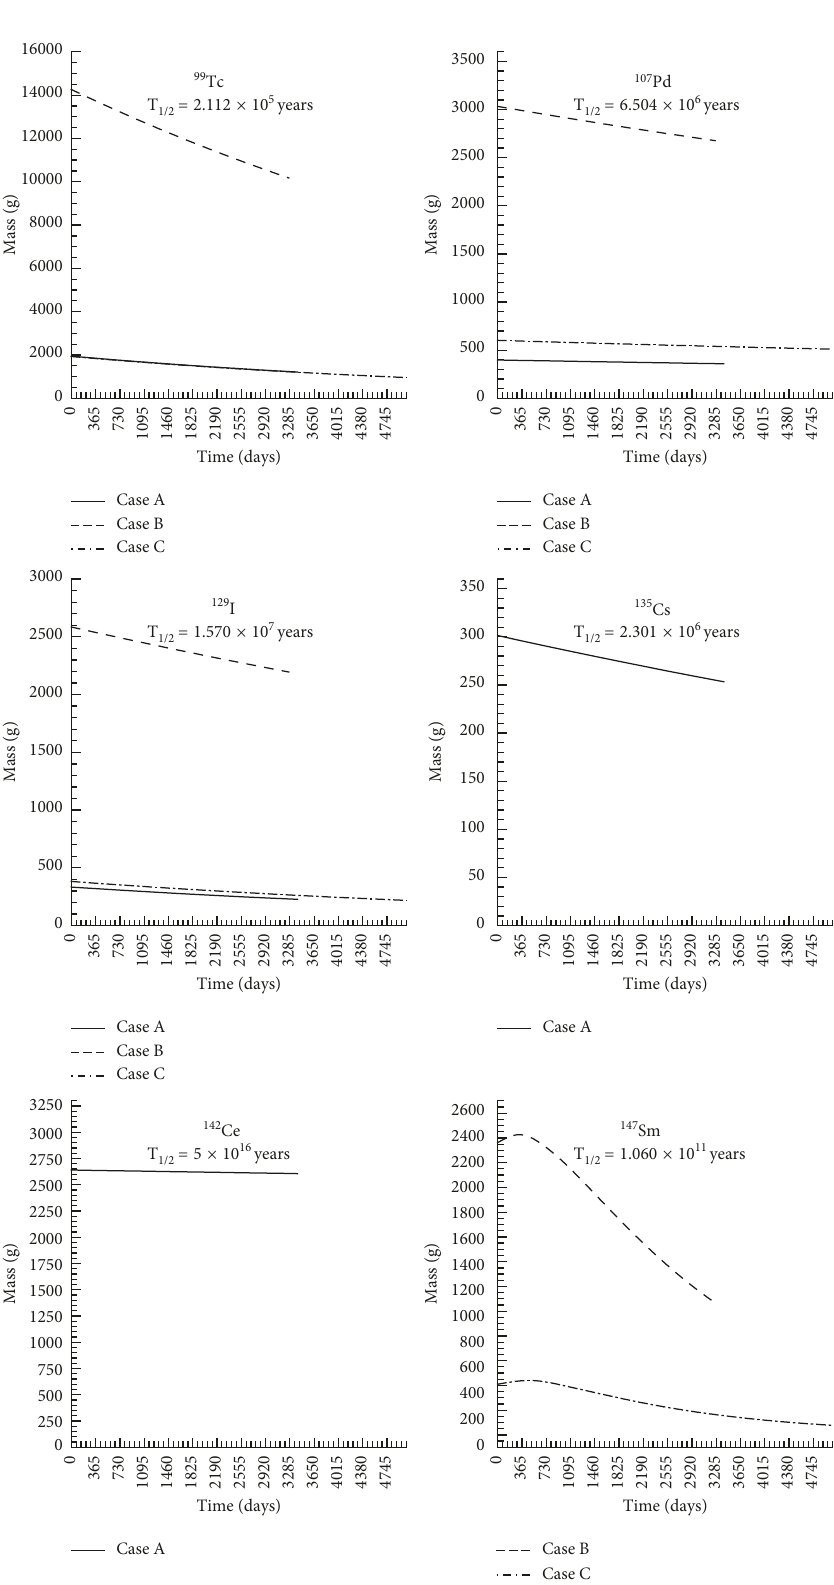
Figure 7: Decrease of masses of LLFPs during the operation